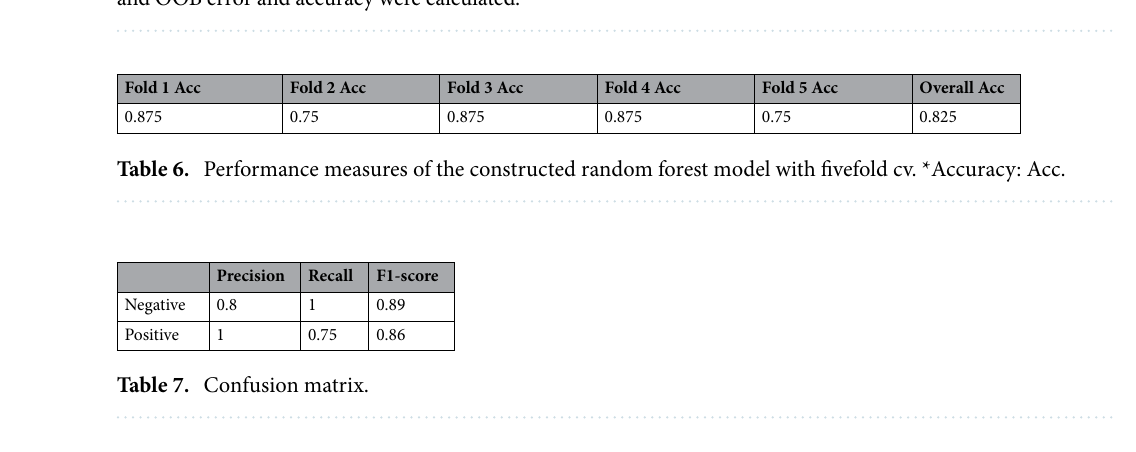
Figure 4. There is a trade-off Between OOB error and accuracy. One by one, trees were added to the algorithm, and OOB error and accuracy were calculated.